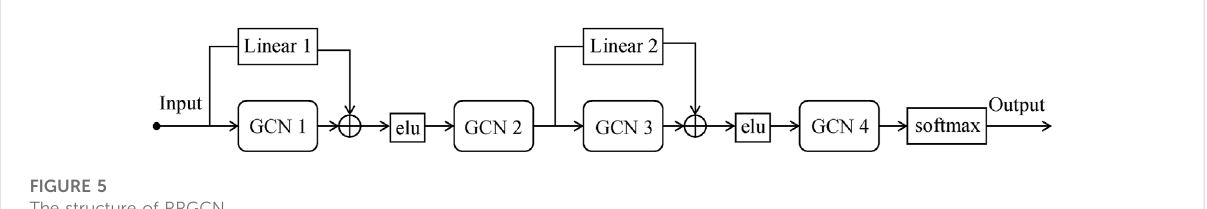
FIGURE 5 The structure of RRGCN.